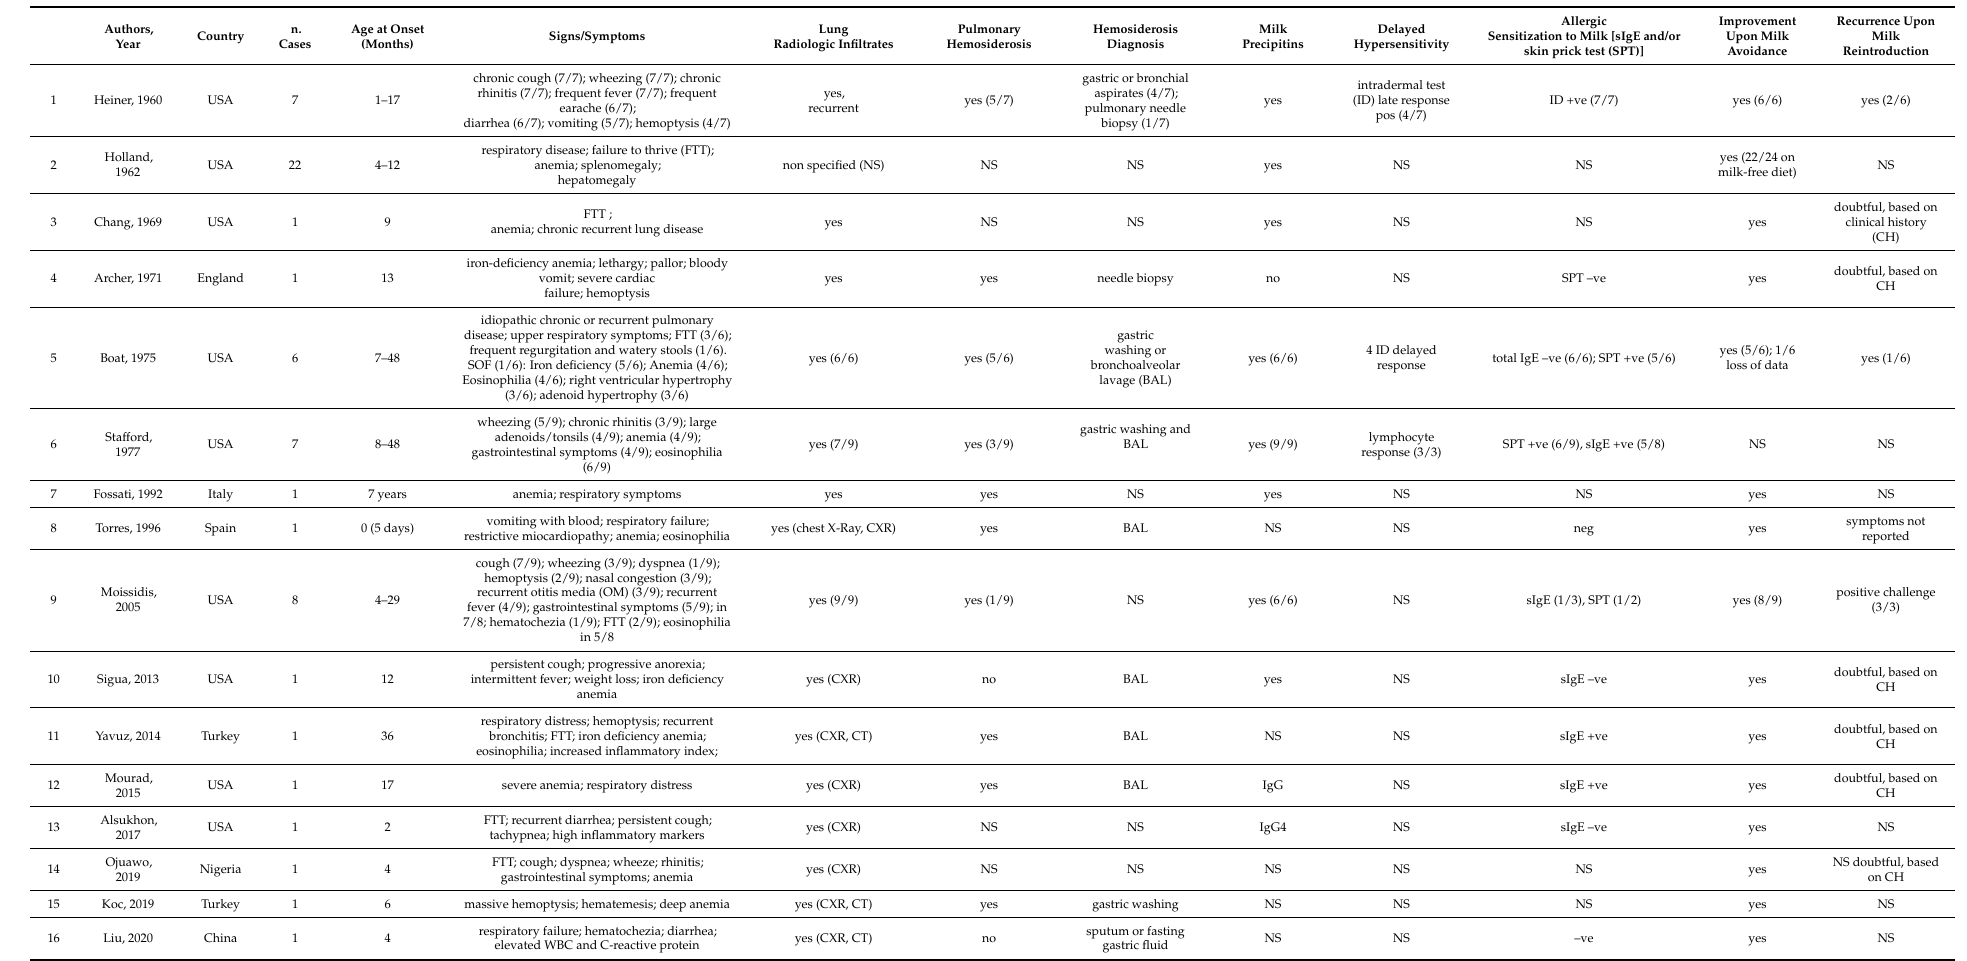
Table 1. Characteristics of the included studies of Heiner